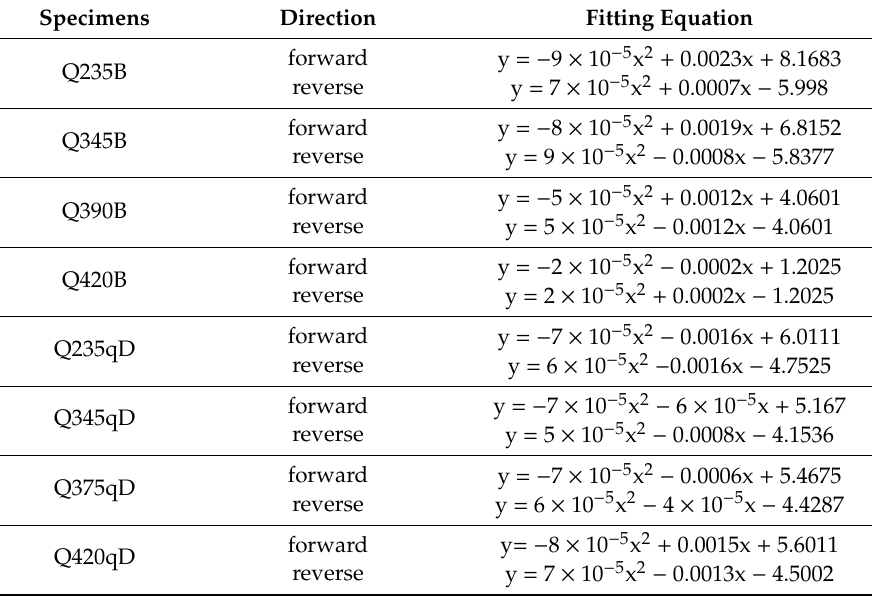
Table 3. The magnetic flux fitting equation for steel specimens with a diameter of 32 mm.